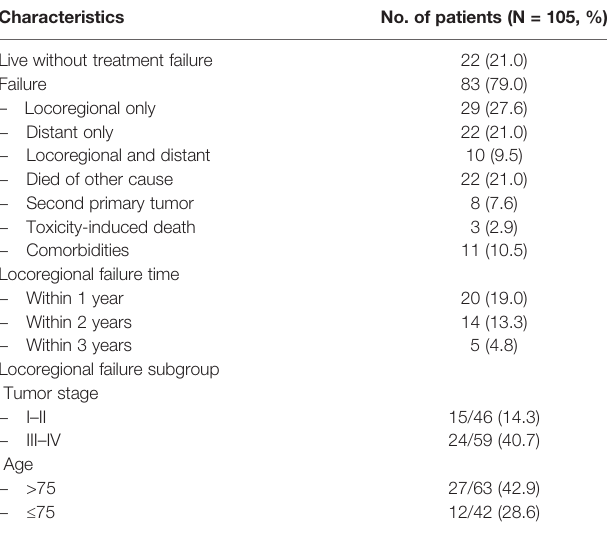
TABLE 2 | Pattern of treatment